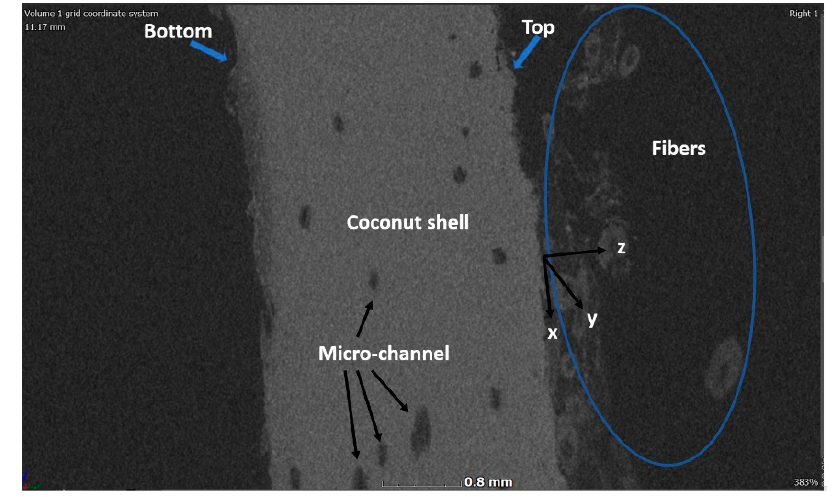
Figure 5. Definition of a coconut coordinate system.